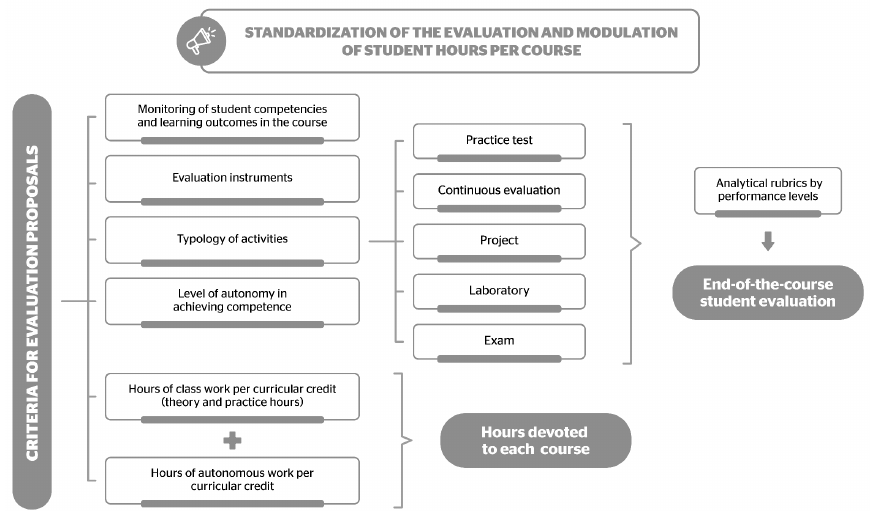
Fig. 8. Standardization of the evaluation and modulation of the student's time